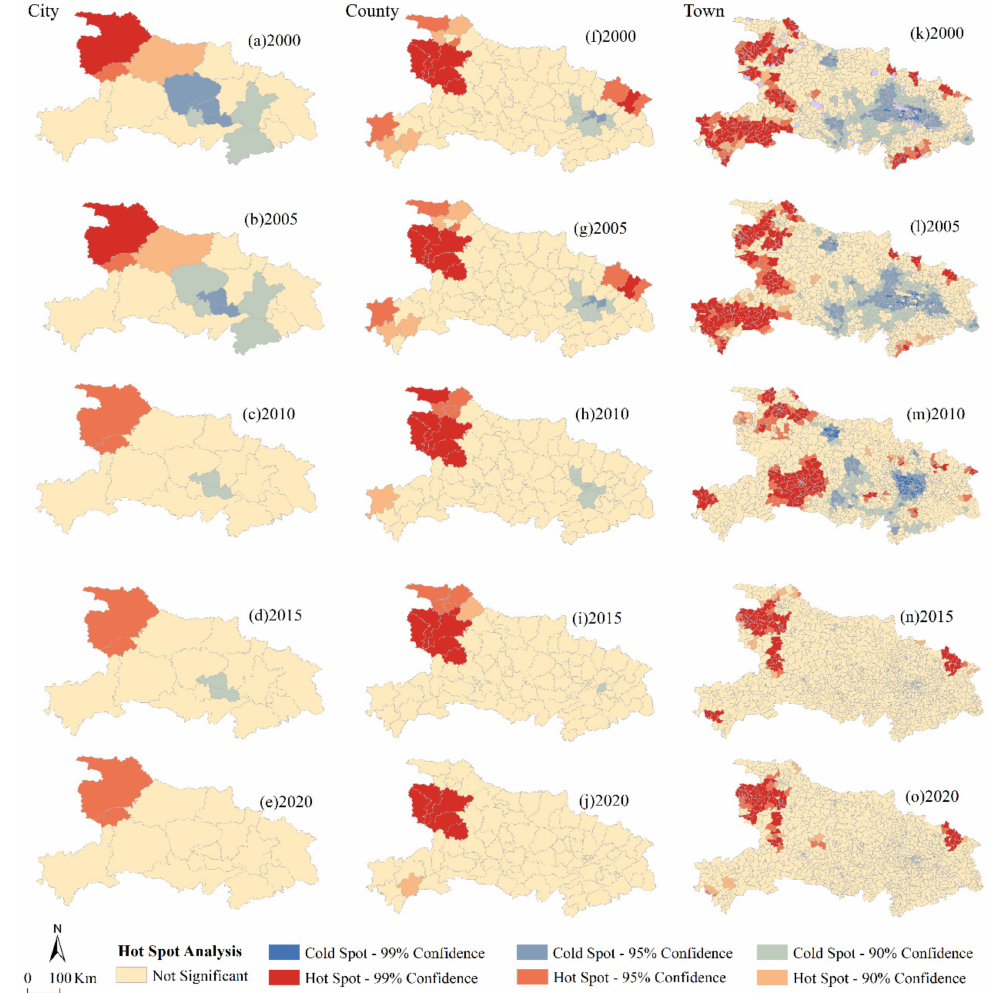
Figure 6. The hotspots and cold spots of soil erosion at ( a – e ) city scale, ( f – j ) county scale, and ( k – o ) town scale from 2000 to